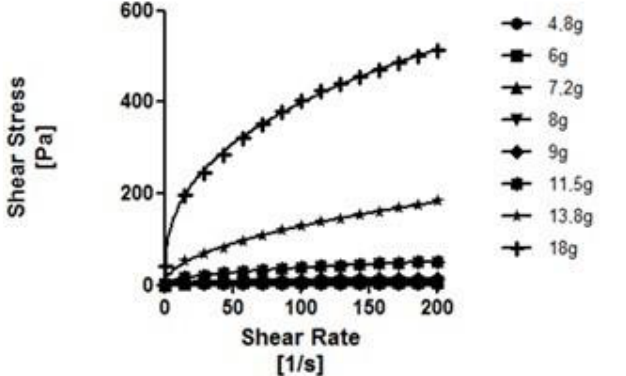
Figure 3. Flow curves at different RC concentrations in water. Solid line represents the Ostwald de Waele rheological model.